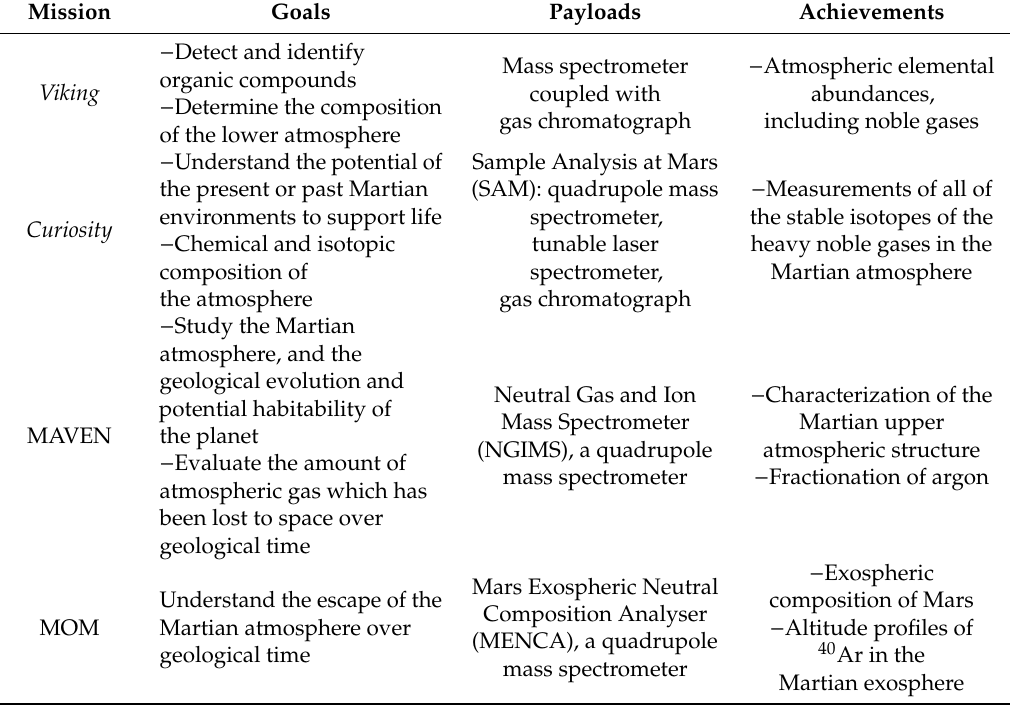
Table 3. List, goals, and achievements of the latest missions to Mars for the measurement of noble gas elemental abundances and isotopic ratios. Mission Goals Payloads Achievements − Atmospheric elemental coupled with